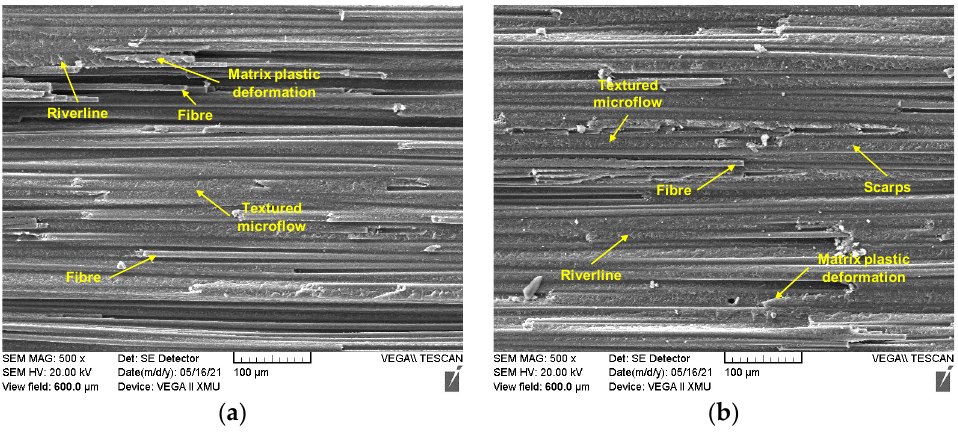
Figure 11. Fracture surface morphology of different off-axis tension specimens: ( a ) 15°; ( b ) 30°. Figure 11b is the SEM image of the fractured 30 ◦ off-axis tension specimen. As the off-axis angle increased, the tension stress component within the matrix increased.